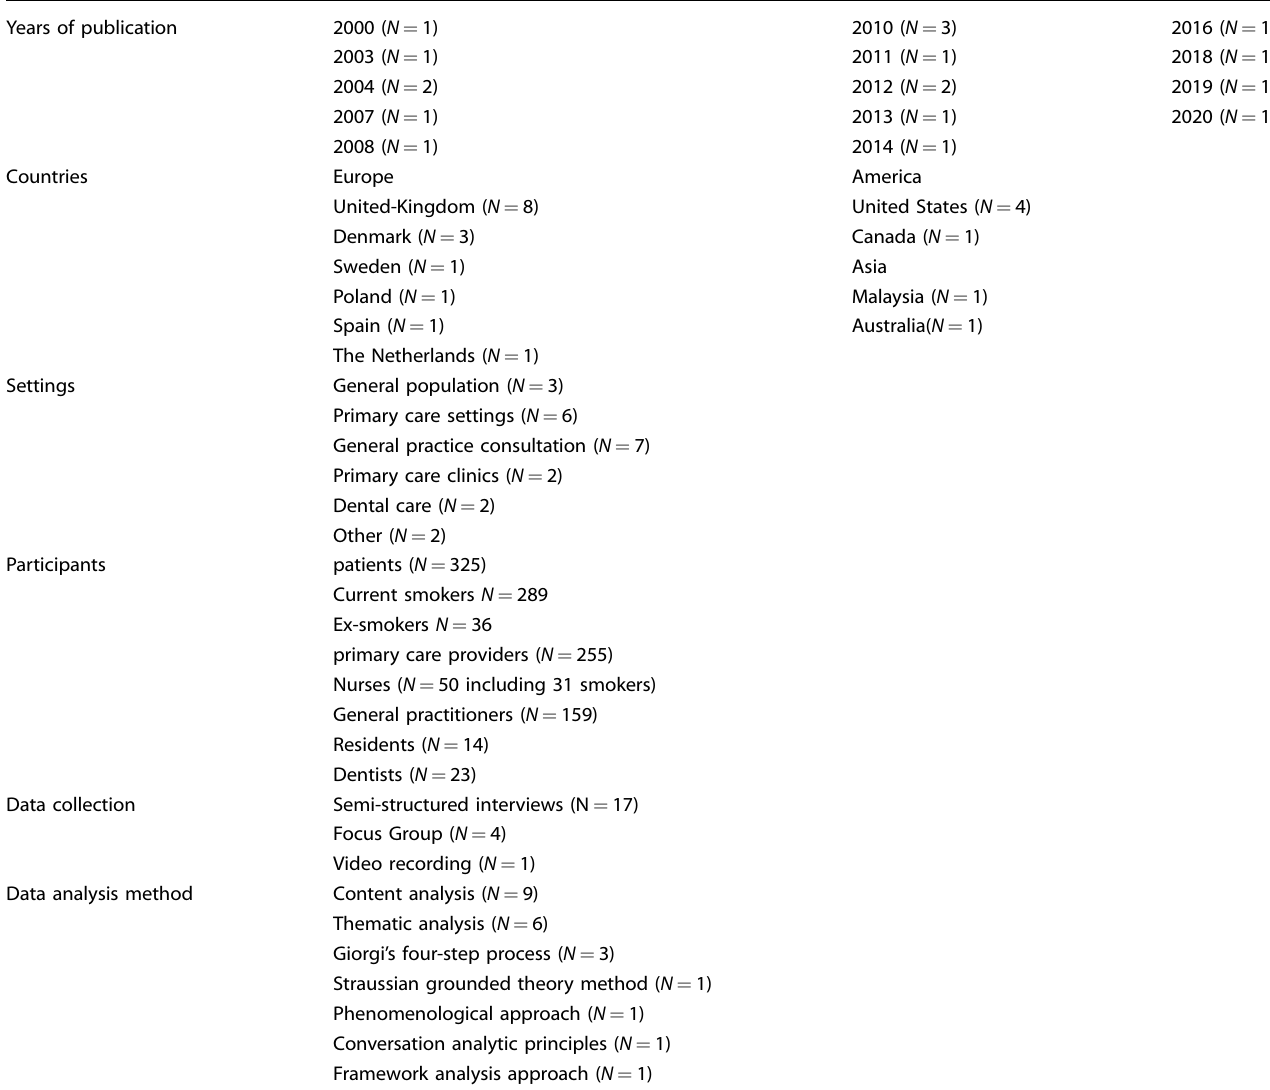
Table 1. Summary of the main characteristics of the included